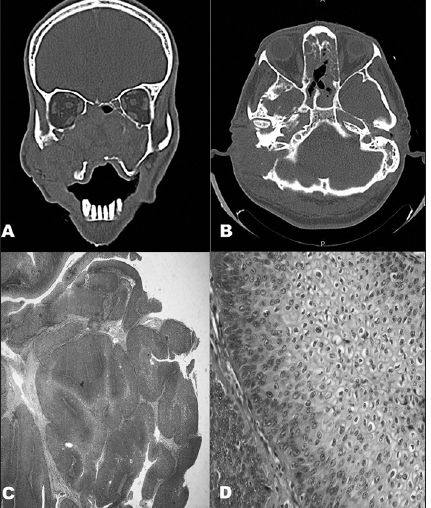
Figura 1. A e B: Tomografia computadorizada de nariz, seios para - nasais e mastoides: lesão de aspecto tumoral com atenuação